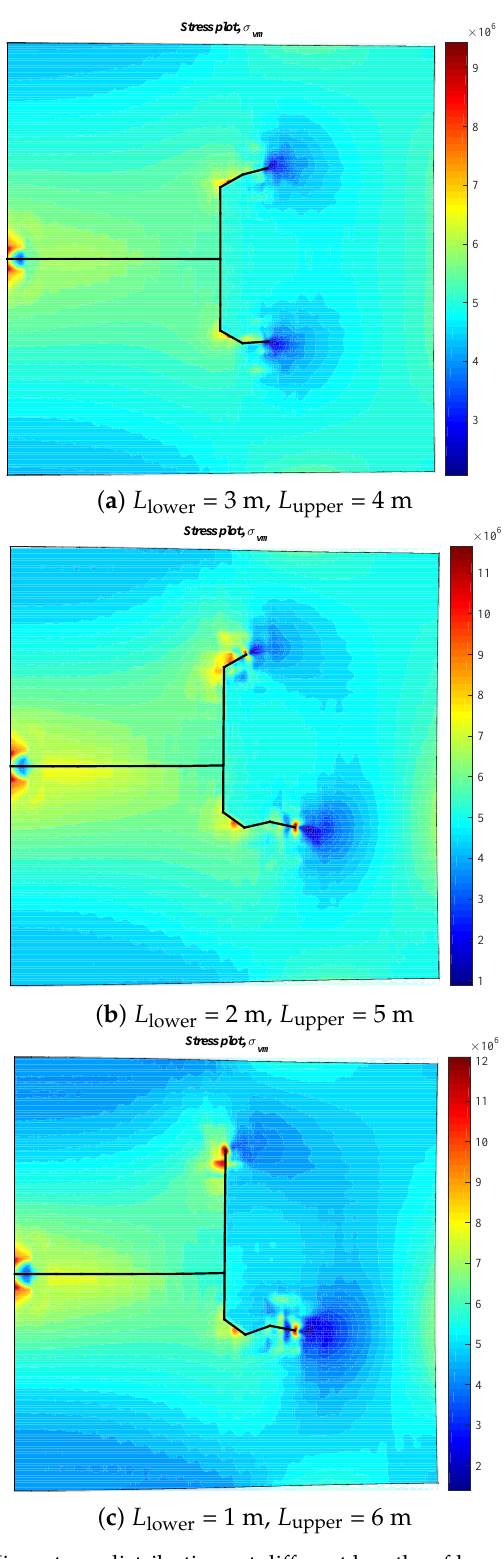
Figure 6. Von-Mises stress distributions at different lengths of lower and upper parts of the NF. The fracture aperture and net pressure curves of the diverted fracture are shown in Figures 7 and 8, respectively. With the decrease of L lower , both curves have revealed an asymmetrical characteristic, which peak at the diverted point in the lower parts. In addition, at the intersection point between